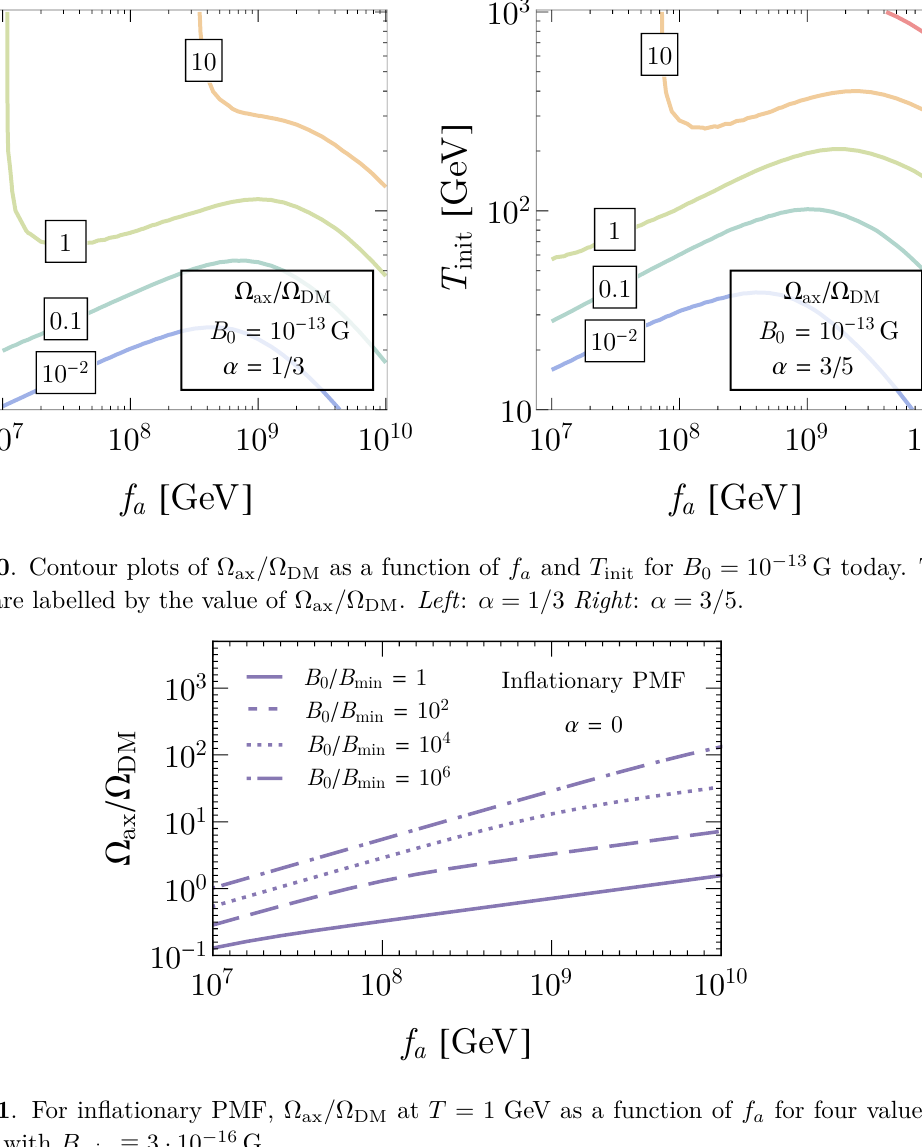
Figure 11 . For inflationary PMF, Ω ax / Ω DM at T = 1 GeV as a function of f a for four values of B 0 today, with B min ≡ 3 · 10 − 16